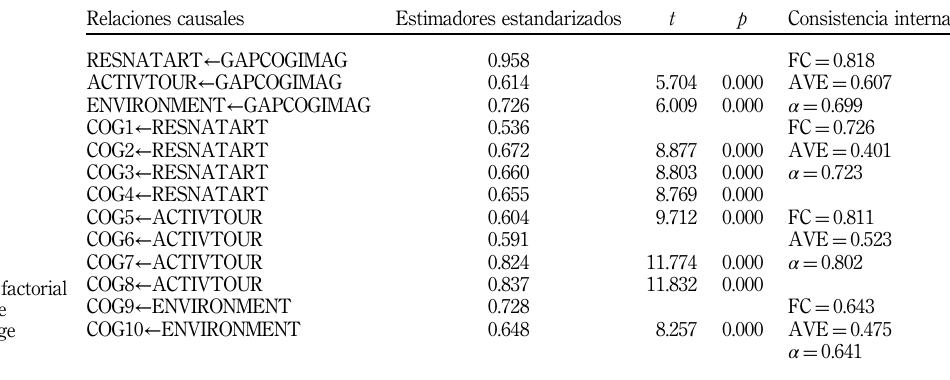
Table II. Confirmatory factorial analysis of the cognitive image gap